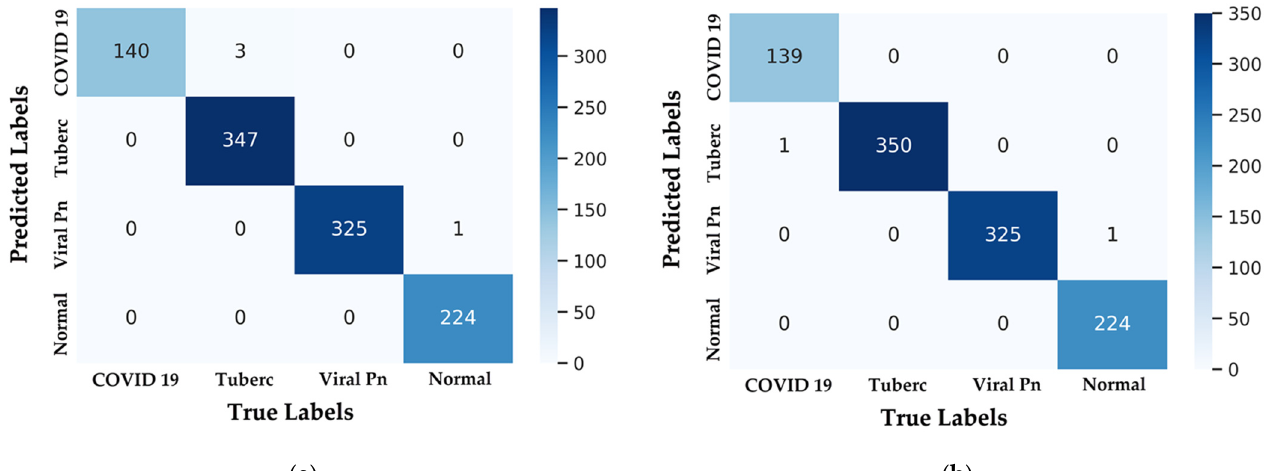
Figure 8. The confusion-matrix demonstrates the Proposed Concatenation classifier. ( a ) Proposed concatenation model based on the modified ResNet50 V2 and MobileNet V2 models, ( b ) Proposed concatenation model based on the modified Xception and Inception V3 models.